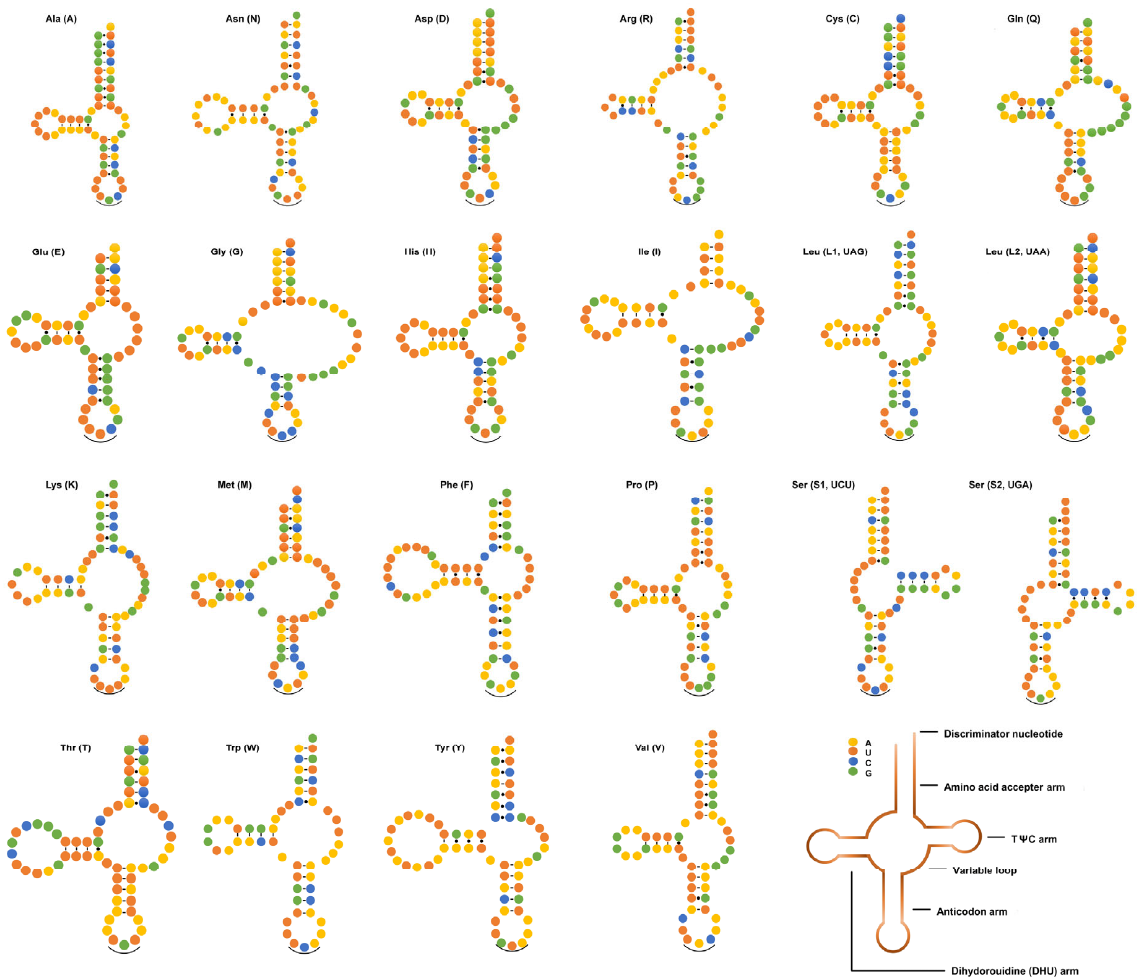
Figure 4. Predicted secondary structures of 22 tRNAs in T. vitulorum mitogenome. The tRNAs are labeled with their corresponding IPUC-IUB single-letter amino acid codes. Dashes ( − ) denote Watson–Crick bonds, dots ( · ) indicate mispaired nucleotide bonds, and ( ‿ ) indicate tRNA anticodons.